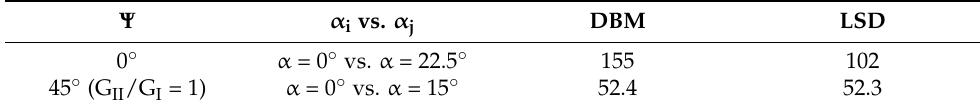
Table 4. They occurred for Mode I and Mixed-Mode I/II loading for Ψ = 45 ◦ only. Table 4. Laminate B: statistically significant